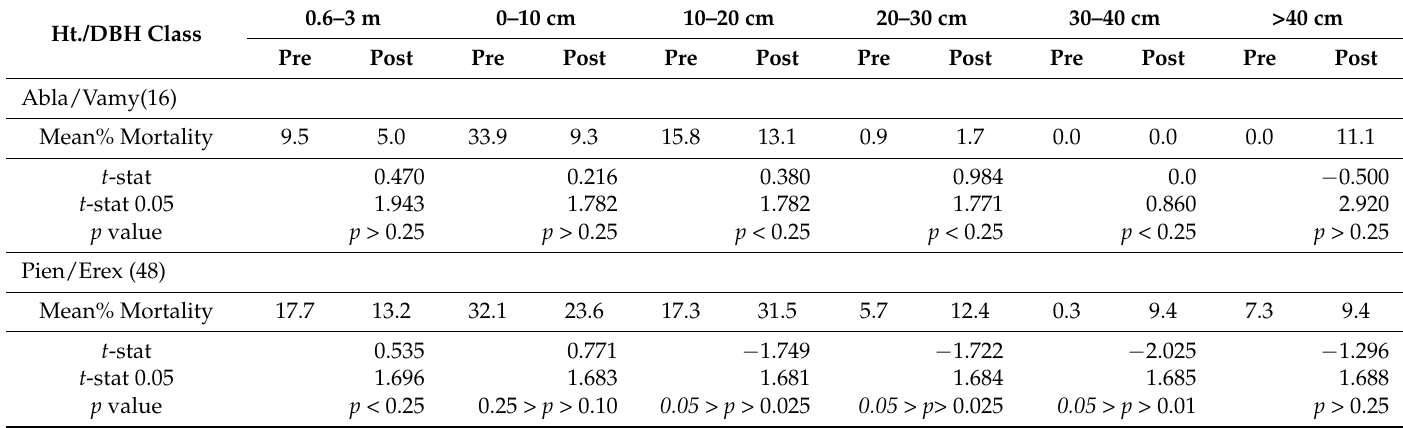
Table 3. Results for two-sample one-tailed T test run on habitat type in the Spruce-fir zone.